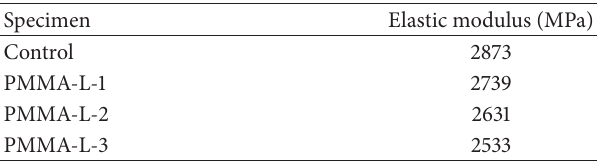
Table1:Valueofelasticmodulusofcompositesamplesderivedfrom TMA